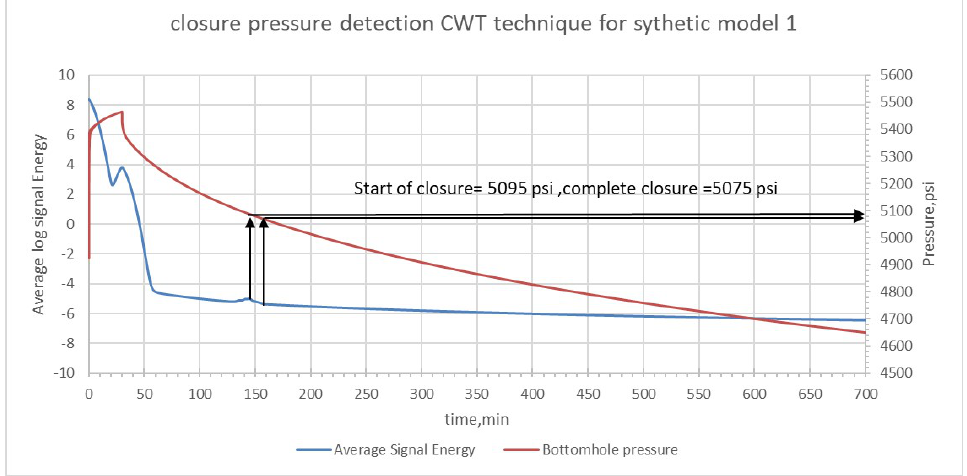
Figure 10. Fracture closure pressure detection using the CWT technique for synthetic model